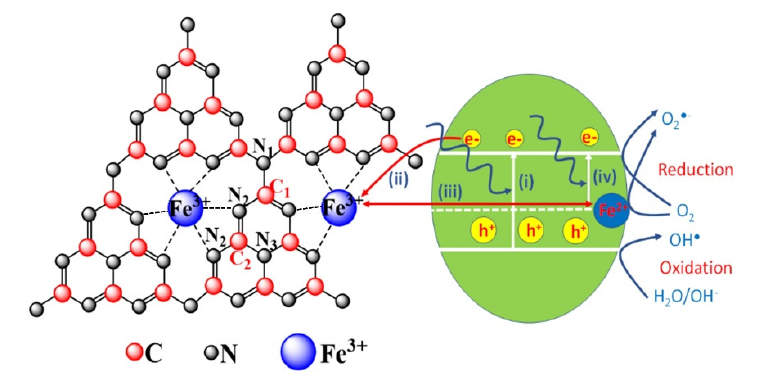
Figure 1. Charge transfer processes in photocatalytic performance of Fe-doped g-C 3 N 4 .